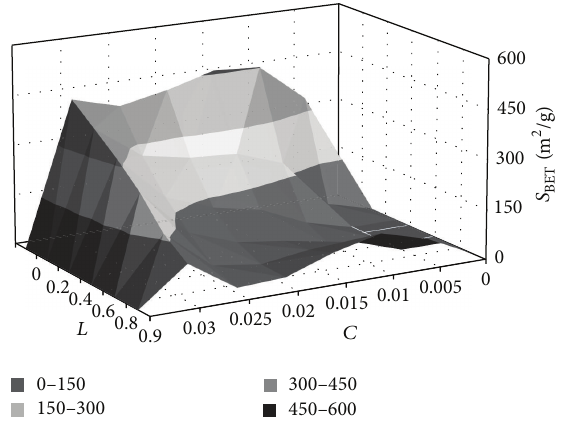
Figure 5: Xerogels specific surface area in function of their compo- sition.